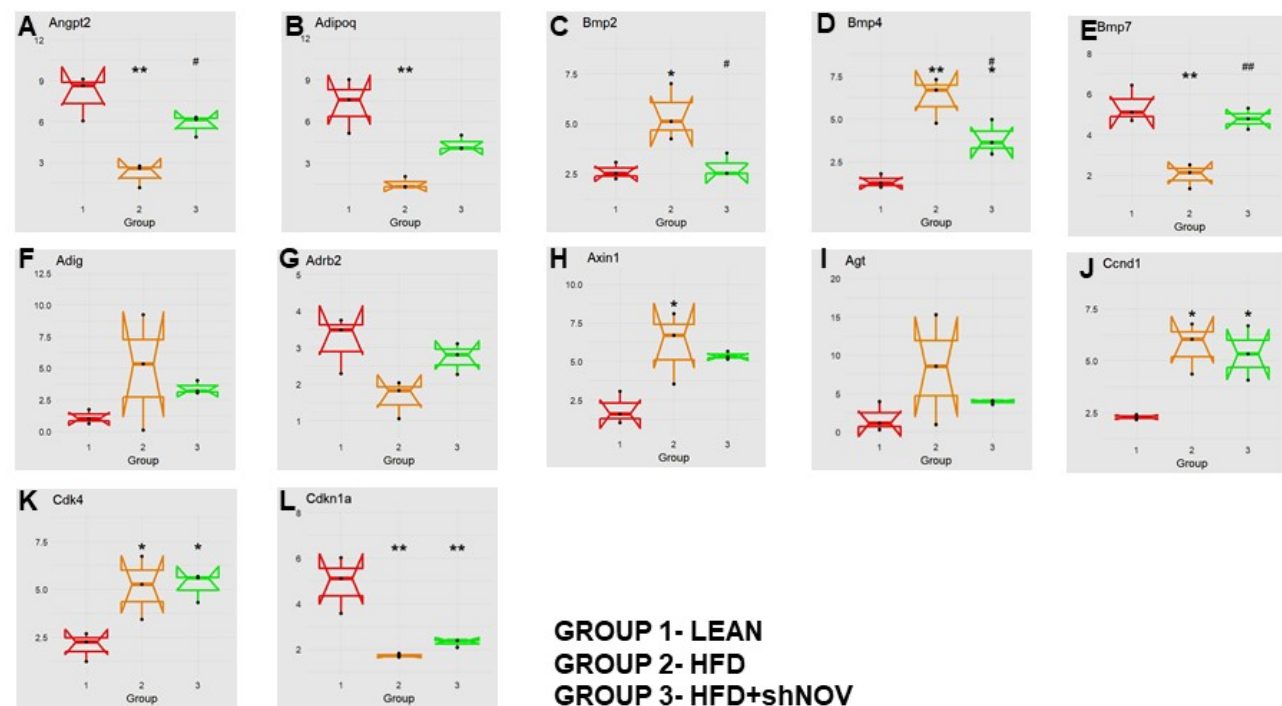
Figure 10. Changes in gene expression in the adipose tissue of shNOV-treated mice (NOV knock- down). RNA-array-analyses changes in the correlation coefficients of gene expression in lean, HFD, and Lnv-adipo-shNOV (HFD) groups. Shown is the mRNA expression (PCR array) of